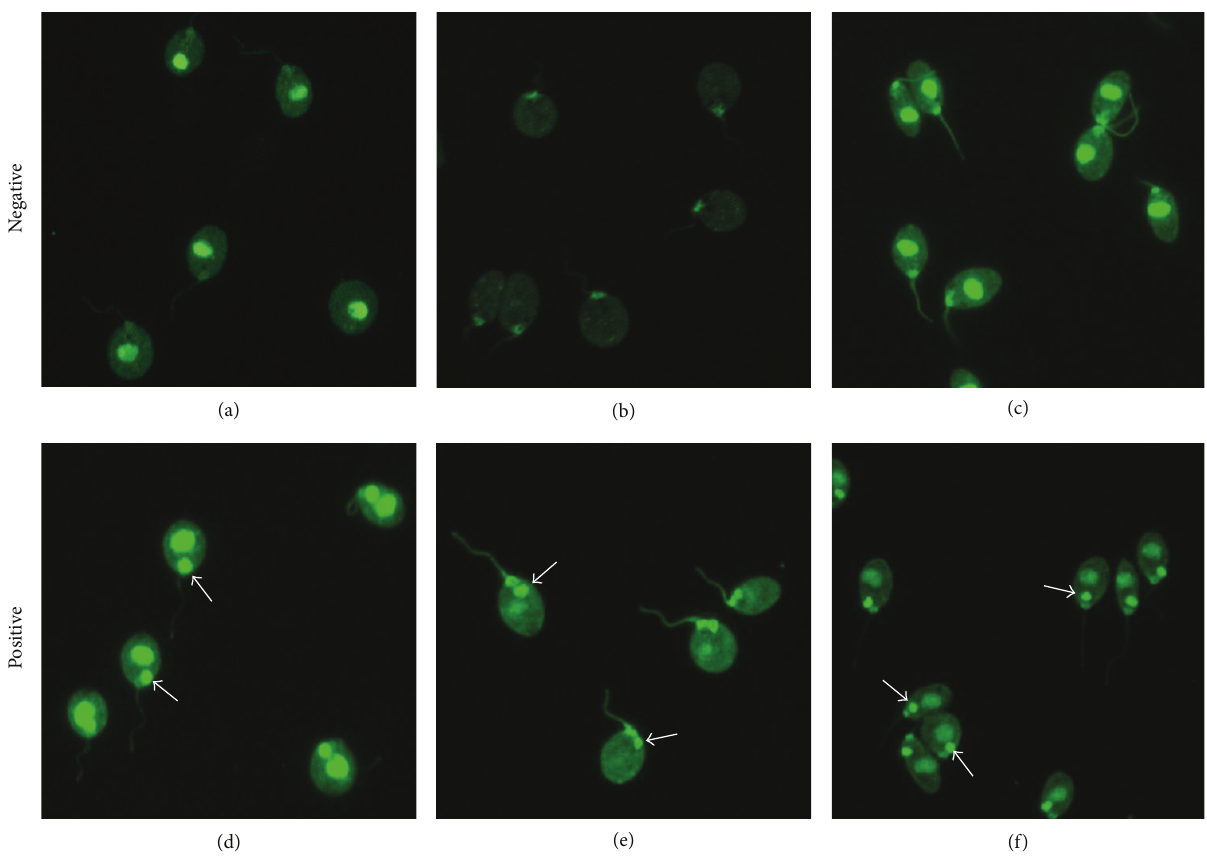
Figure 2: Immunofluorescence patterns on Crithidia luciliae revealing the absence or presence of antibodies against dsDNA. Samples are determined as anti-dsDNA negative if the kinetoplasts of the cells do not fluoresce, irrespective of fluorescent nuclei (a), basal bodies (b), or both (c). Samples are determined as anti-dsDNA positive as soon as the kinetoplasts reveal fluorescence signals above a given threshold (see arrows) which may be accompanied by additional fluorescence of the nuclei (d), the basal body (e), or both